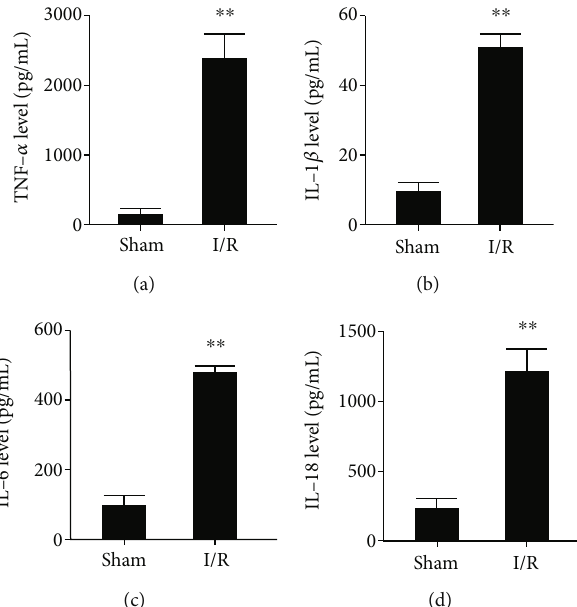
Figure 2: CI/R injury enhances in fl ammatory mediator release. (a) TNF- α level. (b) IL-1 β level. (c) IL-6 level. (d) IL-18 level. The data expressed as mean ± SD . ∗∗ P < 0 : 01 vs.